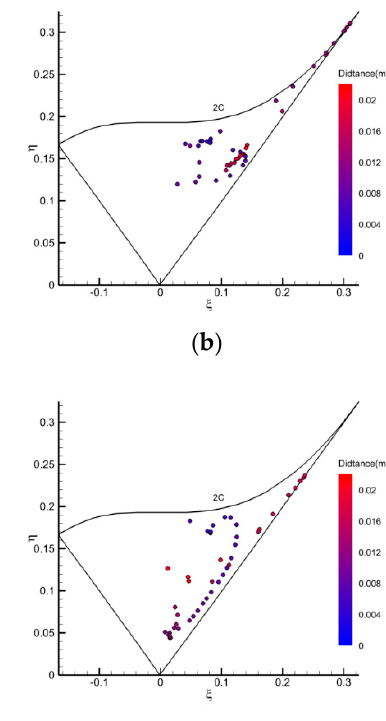
( b ) No.2; ( c ) No.3; ( d ) No.4.